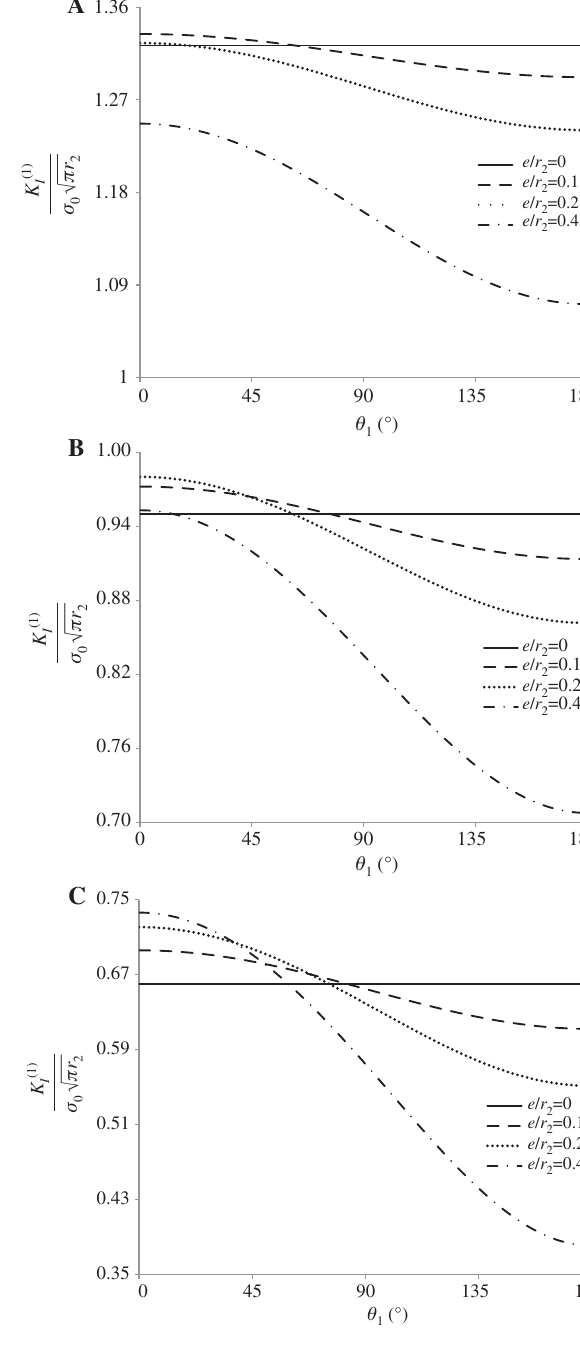
Figure 4: Effect of the eccentricity on the inner stress intensity = 0.1, (B) r = 0.2, and (C) r = 0.4. factor for the cases: (A) r / r / r / r 1 2 1 2 1 2 intensity factors decrease with increasing r / r . For a given 1 2 value of r / r and e / r , the stress intensity factor for the 1 2 2 inner crack edge is larger than that of the outer crack edge. From comparison of the figures pertinent to the outer crack ≠ 0 edge, it is seen that a curve for a given value e / r 2